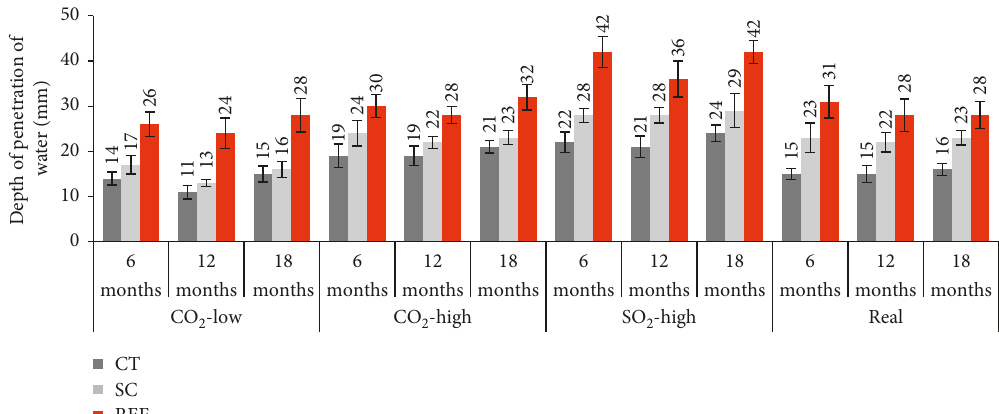
Figure 9: Comparison of depth of penetration of water under pressure in concrete exposed to a gaseous aggressive environment and a real environment. The error bars represent the range of measurements for 3 samples.